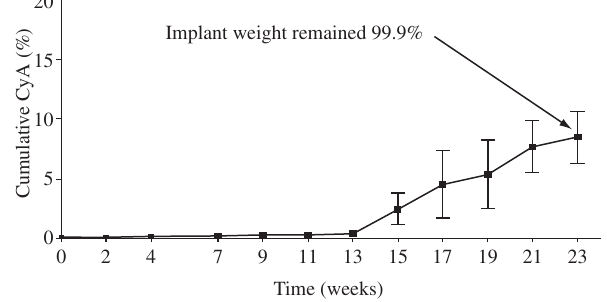
Figure 7. Cumulative release of CyA from: mixture lyophilized implants in PBS buffer 7.4. The values are showed as mean ± SD of n =